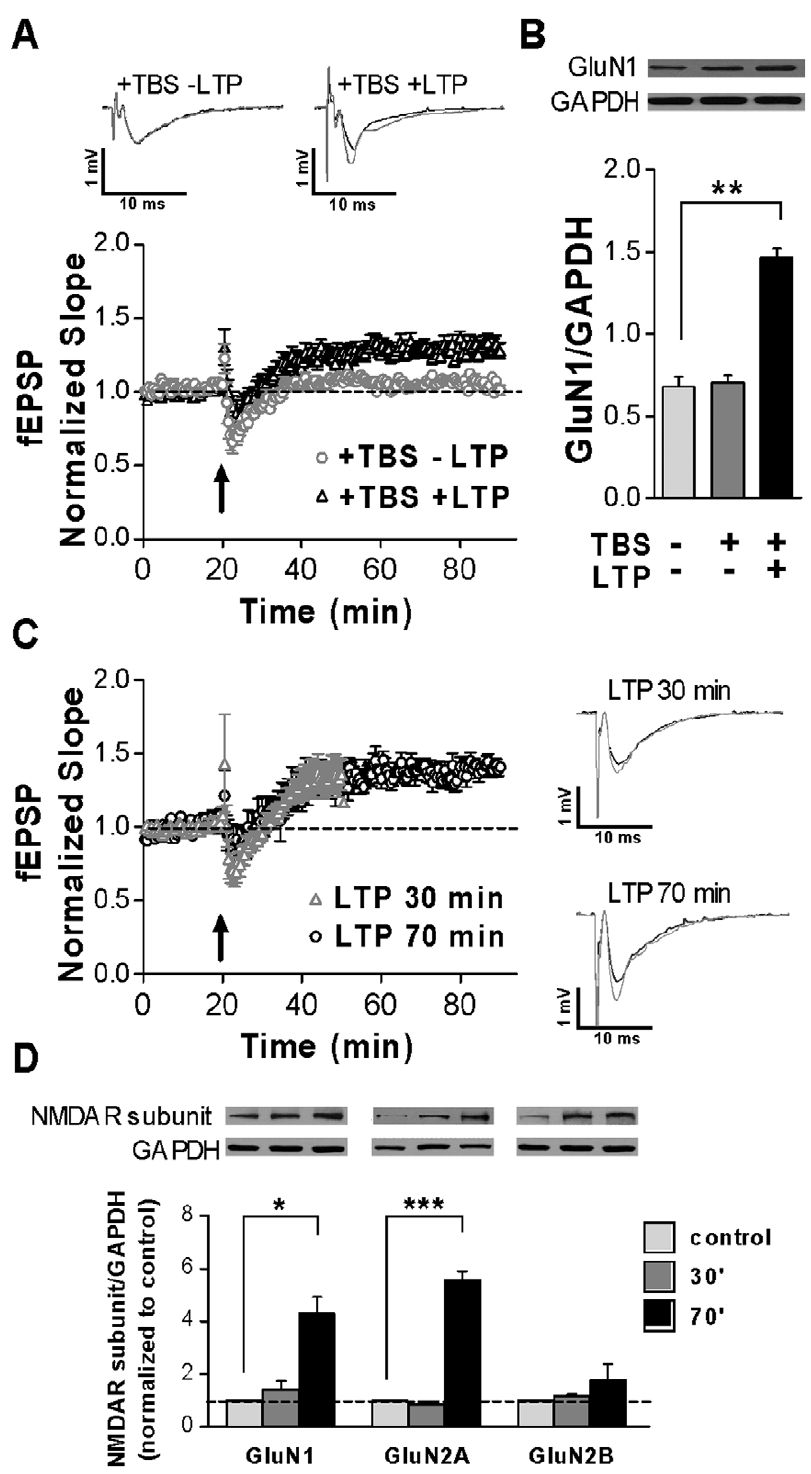
Figure 3. NMDAR subunits change after LTP induction and expression. A. Evoked fEPSPs normalized slopes from fresh hippocampal slices corresponding to the first pulse of paired stimulation, before and after TBS (arrow). Plots represent the average of three independent experiments over 90 minutes of recording (n=6 for each group). Insert on top: average traces of 10 individual recordings from a + TBS + LTP and a + TBS-LTP slices (black: 5 minutes before TBS; grey: 5 last minutes of recording). B. WB band densities quantification of samples from same slices that in A. A significant increase was only observed for + TBS + LTP slices (** p , 0.01; *** p , 0.001 ONE WAY ANOVA, Dunnet Post-Test; n=6 for each group). Insert on top: (from left to right): representative GluN1 and GAPDH WB bands from: a 2 TBS slice, a + TBS-LTP slice and a + TBS + LTP slice. C. Evoked fEPSPs slopes corresponding to the first pulse of the paired stimulation before and after TBS (arrow). Plots represent the average of fEPSPs slopes over 50 and 90 minutes of recording, respectively (n=6 for each group). Right : average traces of 10 individual recordings from a LTP-slice after 30 and 70